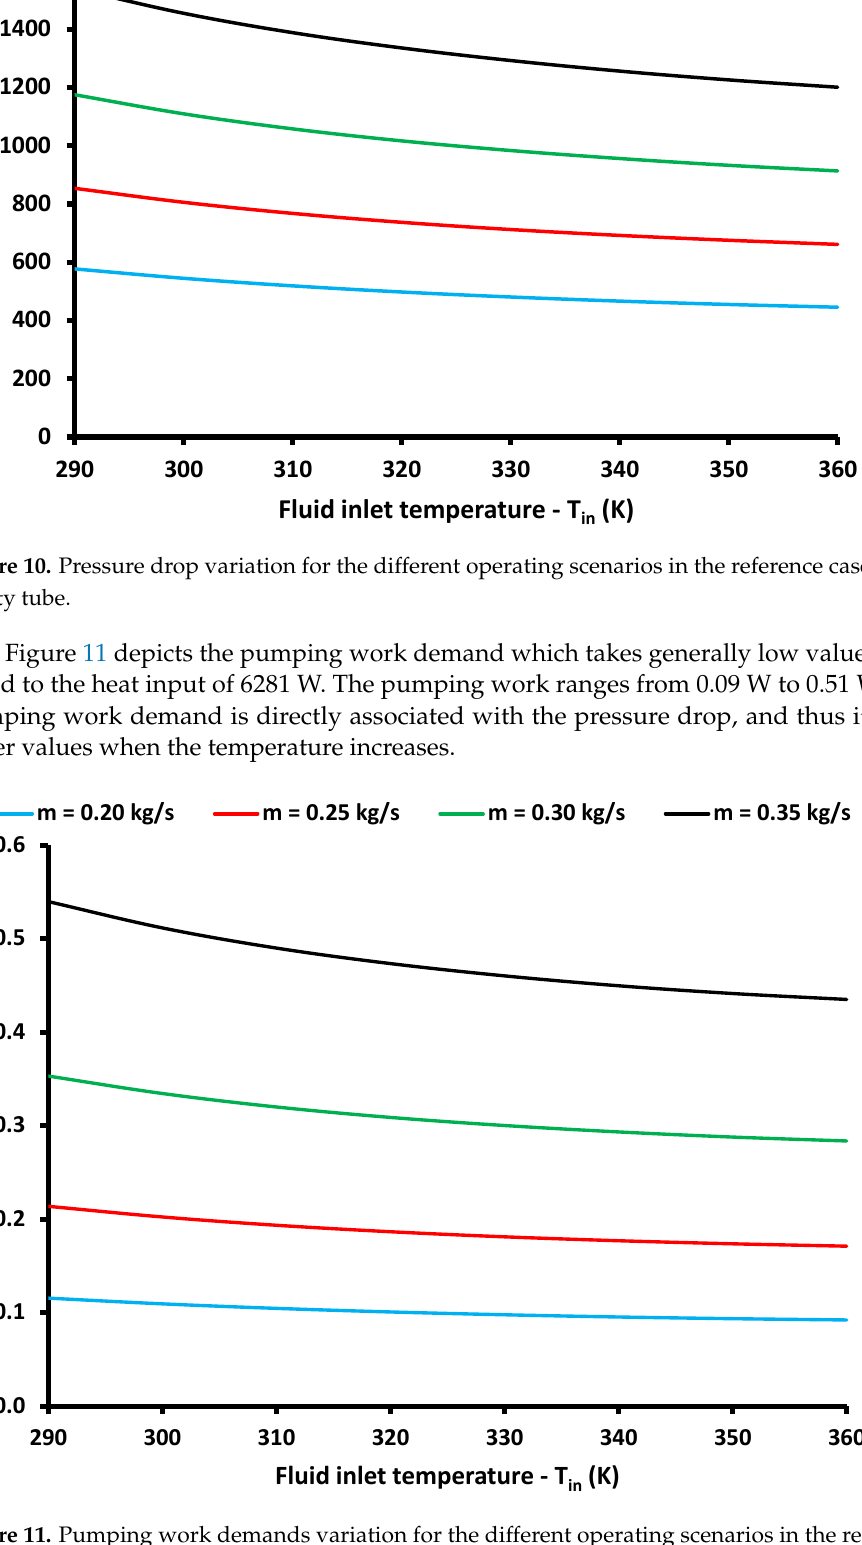
Figure 9. Friction factor variation for the different operating scenarios in the reference case of the empty tube.